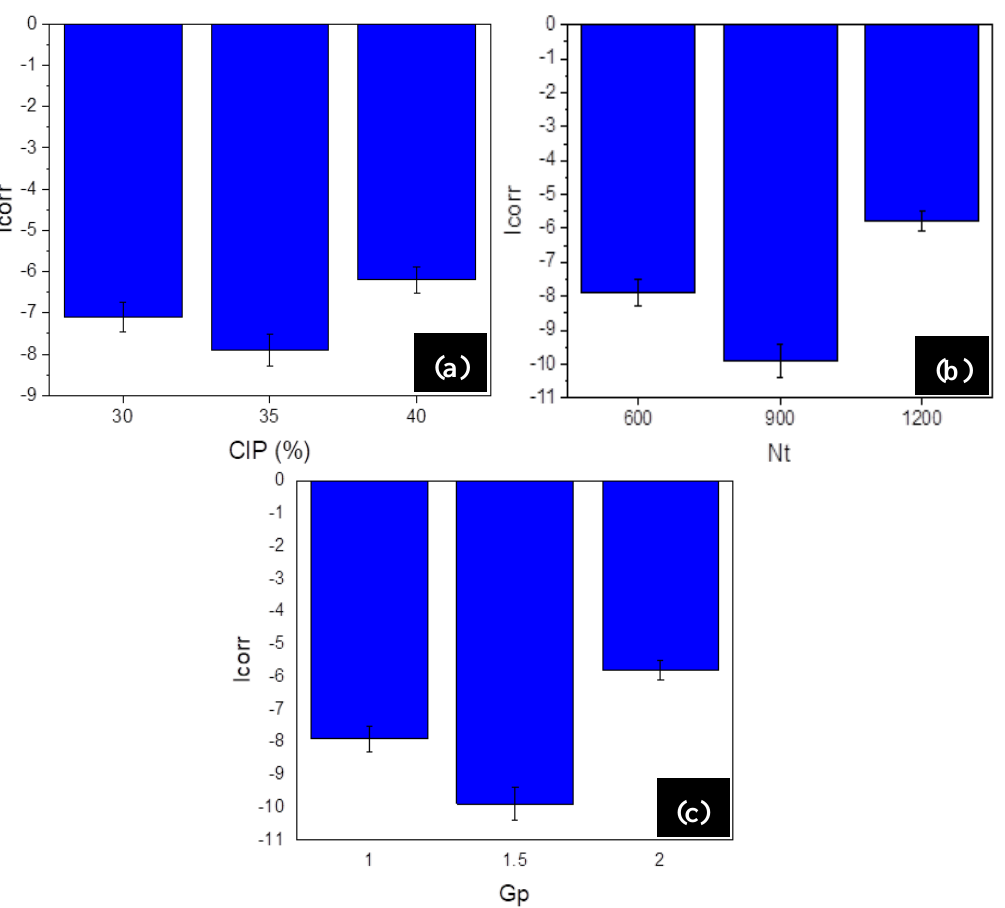
Figure 5. Results of ICOR for set #1 ( a ), set #2 ( b ), and set #3 ( c ). (Note: The unit of ICOR is µ A / cm 2